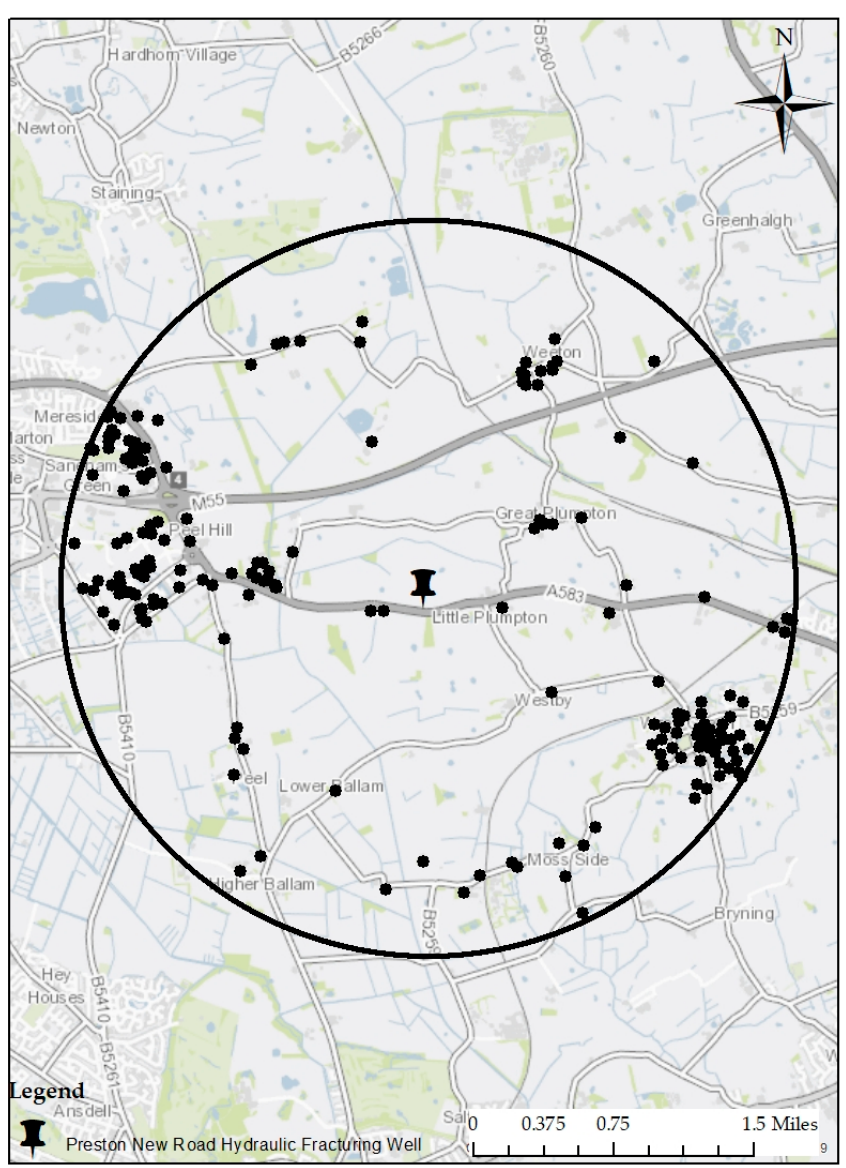
Figure 2. Post code areas surveyed near Preston New Road.